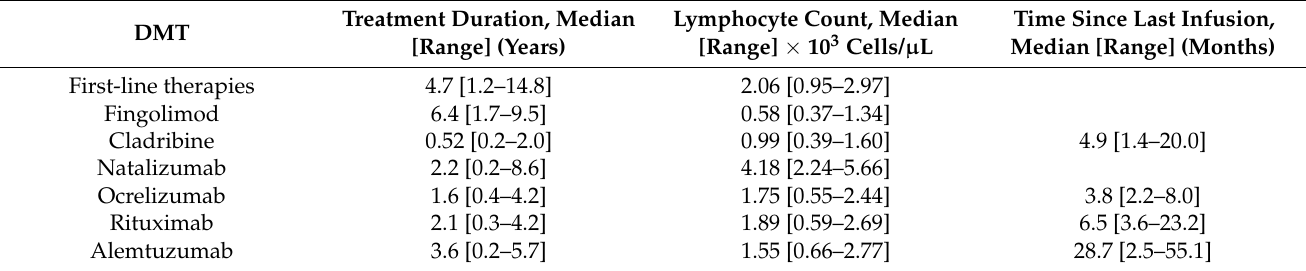
Table 2. Treatment characteristics at the first vaccine